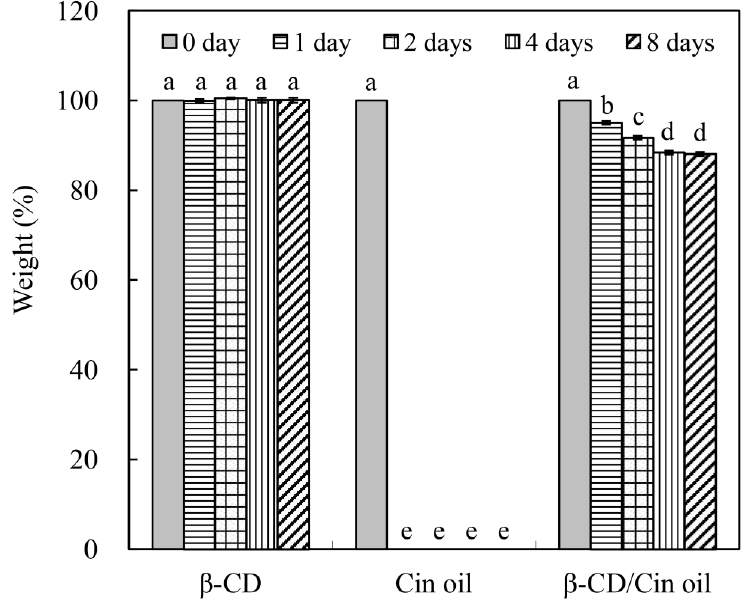
Figure 3. Changes in weight of leaf oil microcapsules during the dry-heat aging test. β-CD: β-cyclodextrin; Cin oil: C. osmophloeum leaf oil; β-CD/Cin oil: leaf oil microcapsules; Different letters (a–e) in the Figure refer to statistically significant difference at the level of p < 0.05 according to the Scheffe’s test.